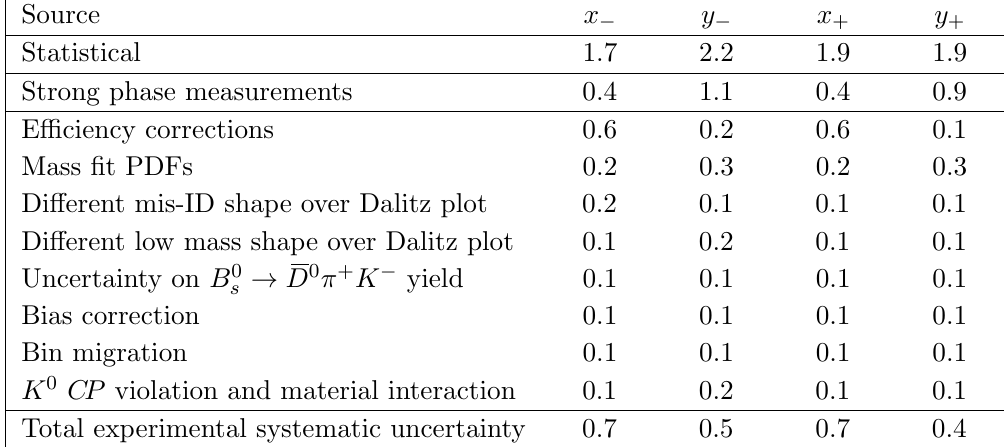
! D 0 (cid:25) + K (cid:0) yield s